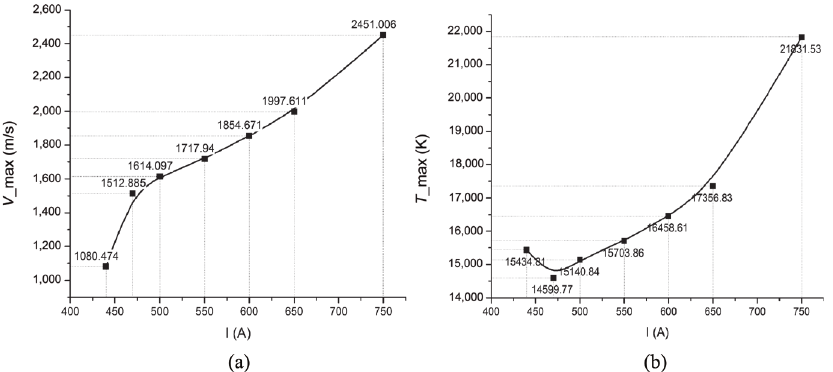
Figure 9: Evolution of (a) maximum velo- city of plasma jet versus the current intensity and of (b) maximum tempera- ture of plasma jet versus the current intensity.